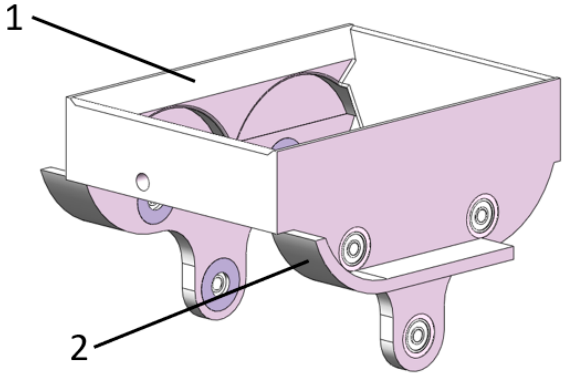
Figure 6. Structure of multi-functional frame: 1—micro-gap guardrail and 2—weigh-in-motion plate.